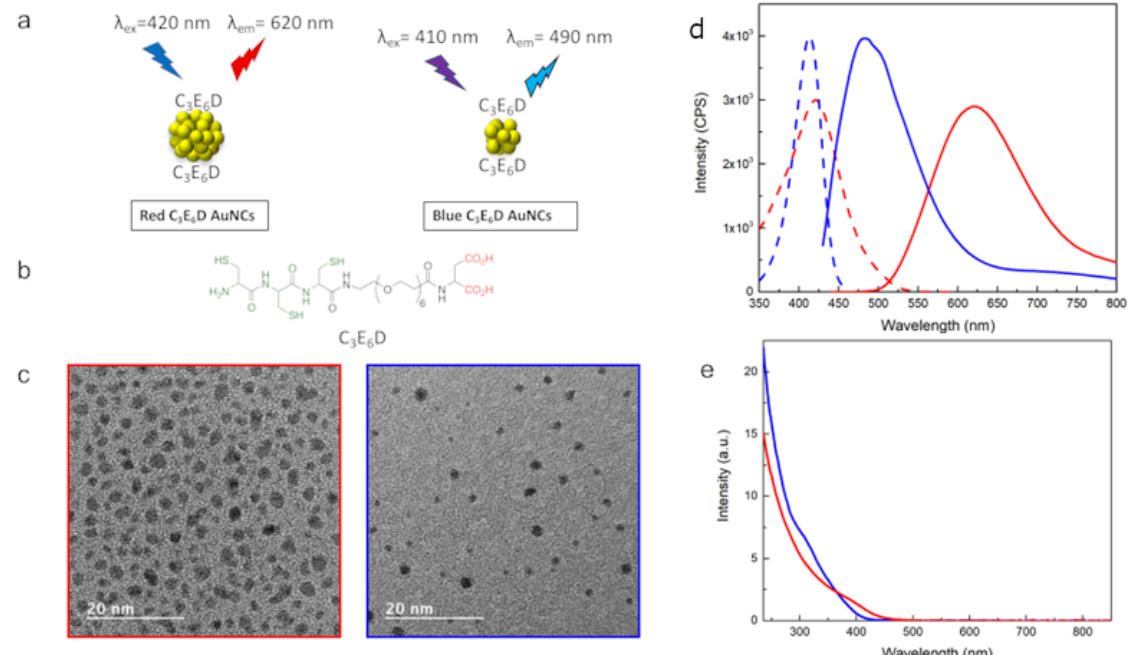
Figure 1. ( a ) Schematic view of Red and Blue NCs. ( b ) Chemical structure of NCs’ ligand C 3 E 6 D. ( c ) TEM micrographs, ( d ) luminescence excitation (dotted lines), and emission spectra (solid lines), and ( e ) absorbance spectra of C 3 E 6 D Blue and Red NCs (blue and red line, respectively).